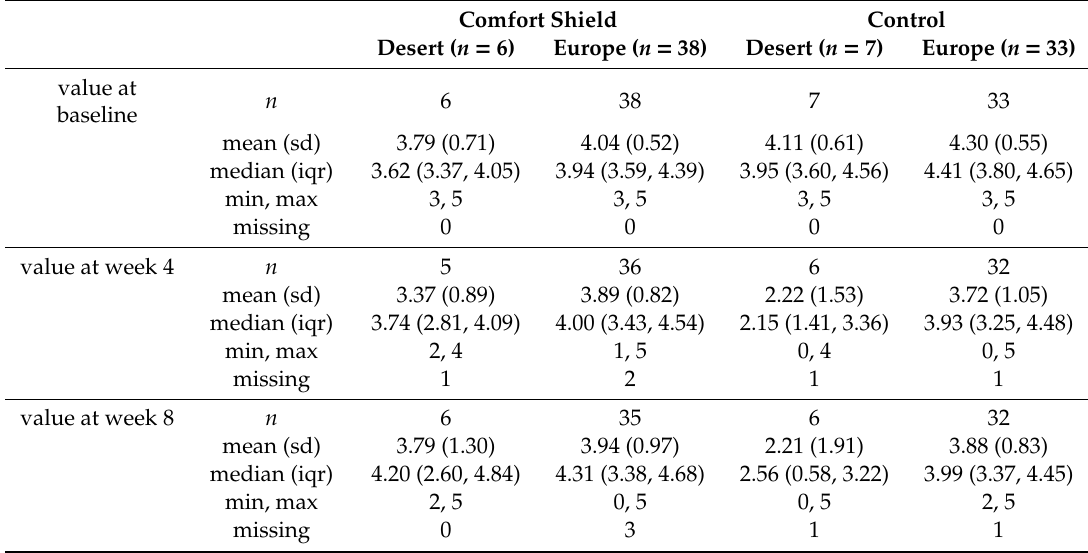
Table A5. CFS: value at baseline and at each post-baseline visit—PPS ( n = 84)—descriptive analysis by